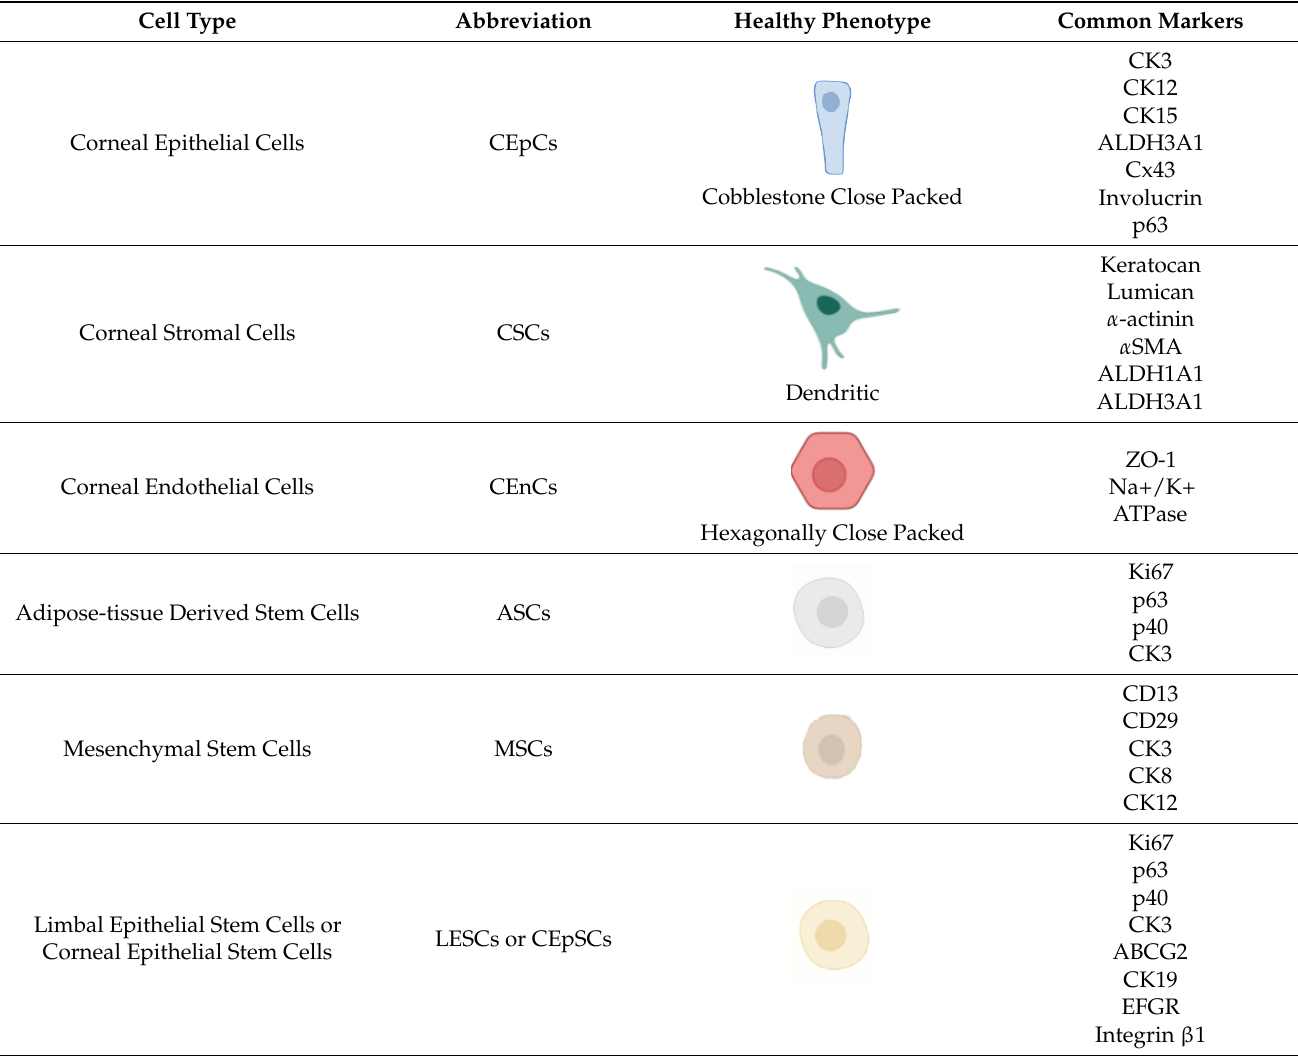
Table 1. Cell types used in corneal tissue engineering.